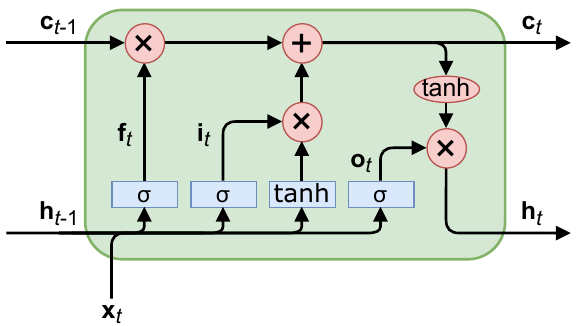
Figure 1. A long short-term memory cell, where blue rectangles indicate trainable parameters and red ovals indicate a math operation